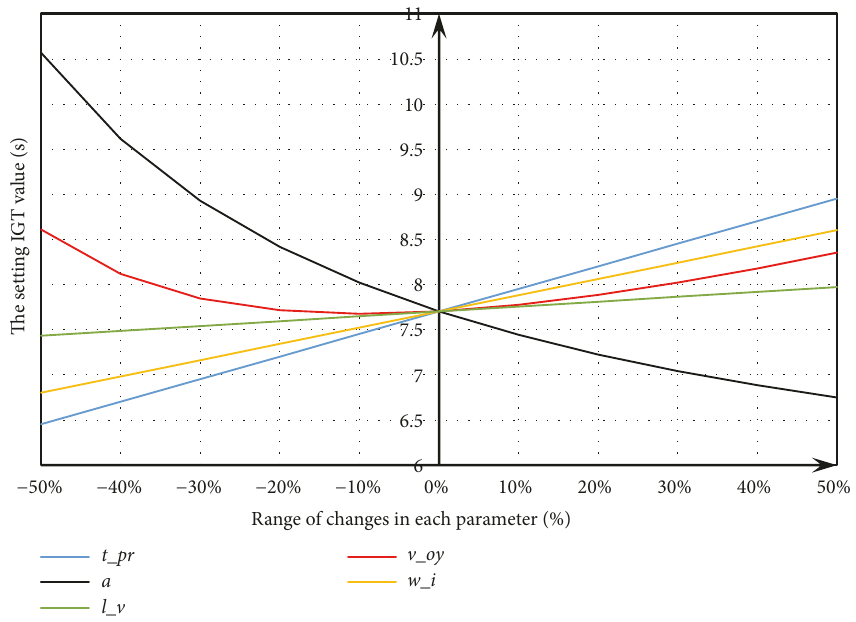
Figure 3: The sensitivity analysis diagram of vehicular IGT in